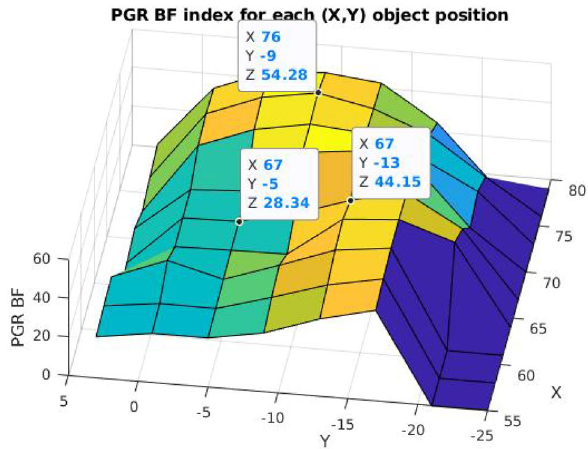
Fig. 7 Top view of Vizzy’s hand on the respective X and Y axes. Object positions in the subsquent figures are with respect to Vizzy’s hand reference frame Fig. 8 PGR indices for each (X,Y) positions of the sphere